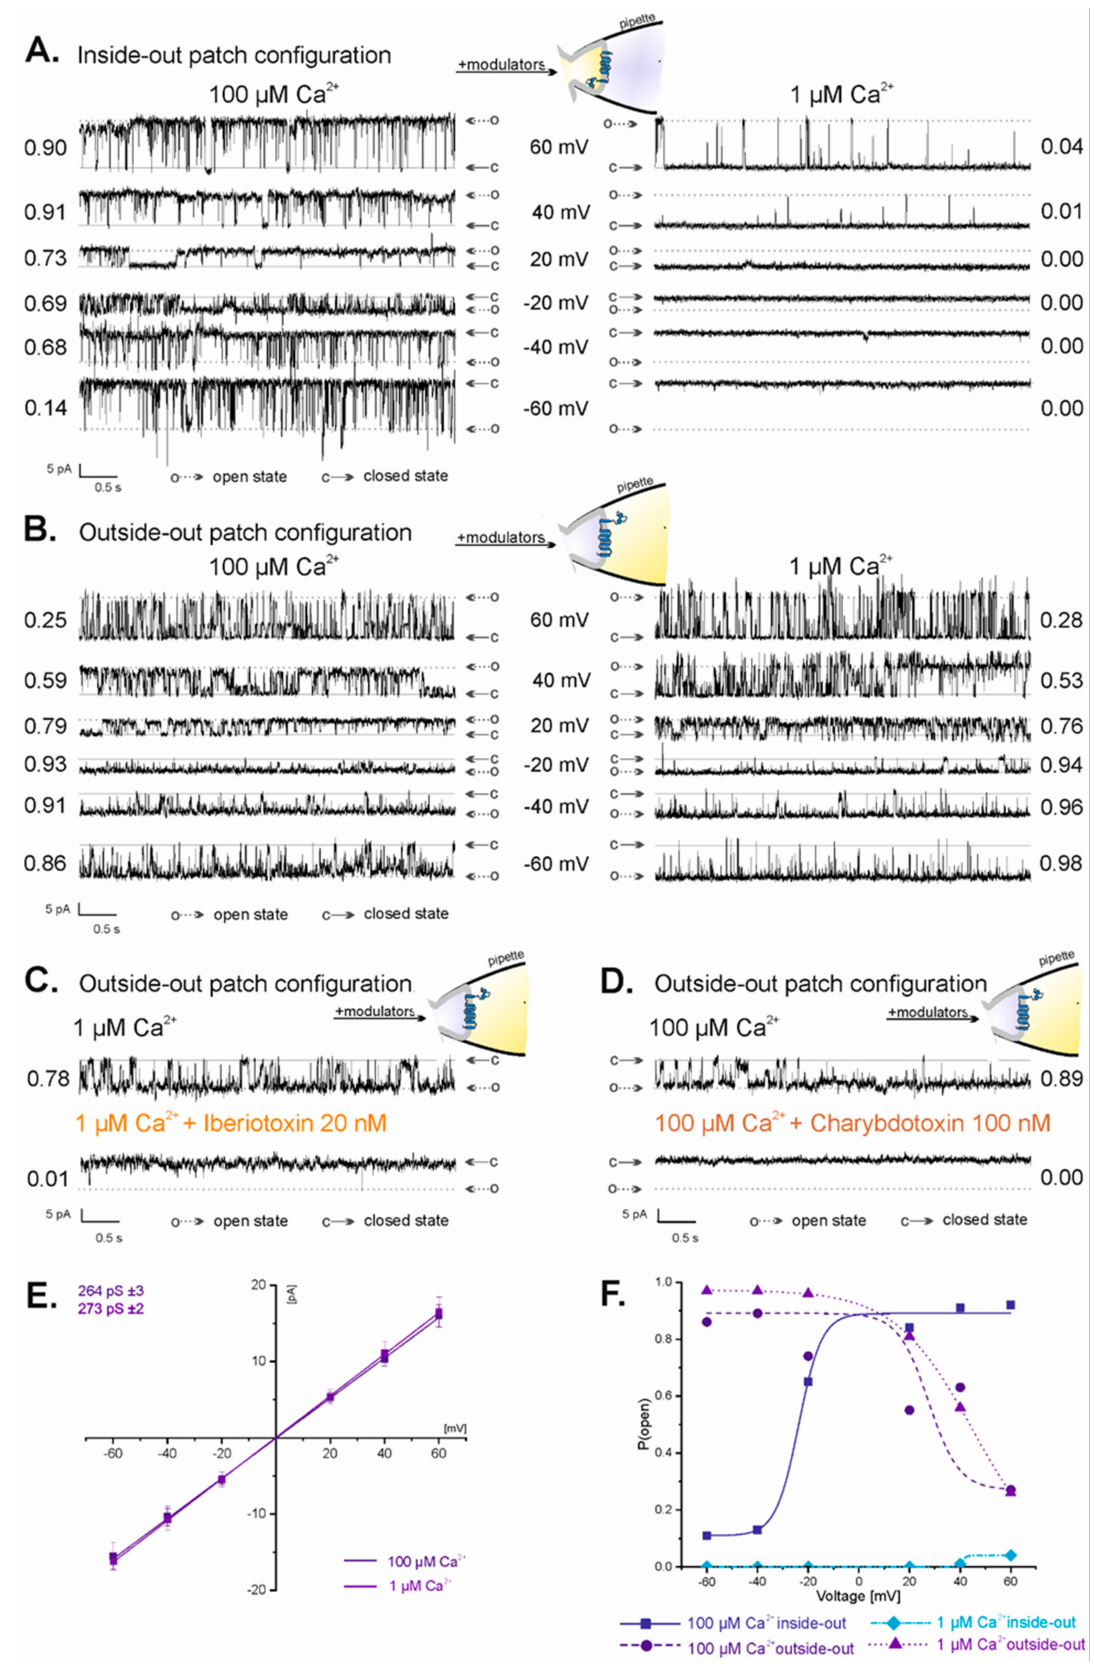
Figure 2. Properties of the mitoBK Ca channel in the inside-out and outside-out configuration. ( A ) Reg- ulation of the mitoBK Ca channel in the inside-out configuration by batch Ca 2+ .